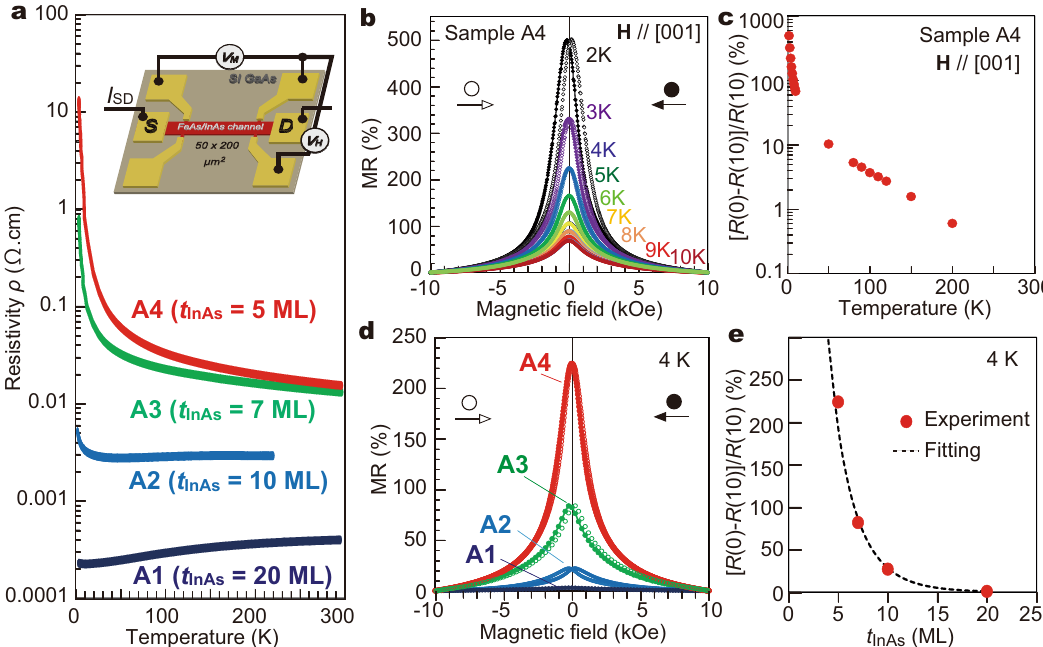
Fig. 3 Magnetotransport properties of the FeAs/InAs SL structures. a Temperature dependence of the resistivity in sample A1 – A4. The resistivity was measured by the four-terminal method in Hall bars with size of 50 × 200 μ m 2 (inset). b Magnetoresistance (MR) curves measured in sample A4 at various temperatures T = 2 – 10 K, when applying a magnetic fi eld perpendicular to the fi lm plane. The MR ratio is de fi ned as MR ( H ) = [ R (0) – R ( H )]/ R ( H ) × 100%. Open and closed symbols in the MR curve at each temperature correspond to the MR ratios under a left-to-right and right-to-left magnetic fi eld sweeping direction, respectively. c MR ratio at H = 10 kOe as a function of temperature in sample A4. d MR curves measured in sample A1 – A4 at 4 K when applying a magnetic fi eld perpendicular to the fi lm plane. Open and closed symbols correspond to opposite sweeping directions of magnetic fi eld, as described in ( b ). e MR ratio at H = 10 kOe as a function of the distance t InAs between the FeAs layers. The relationship can be fi tted well by Eq. (4) (dotted